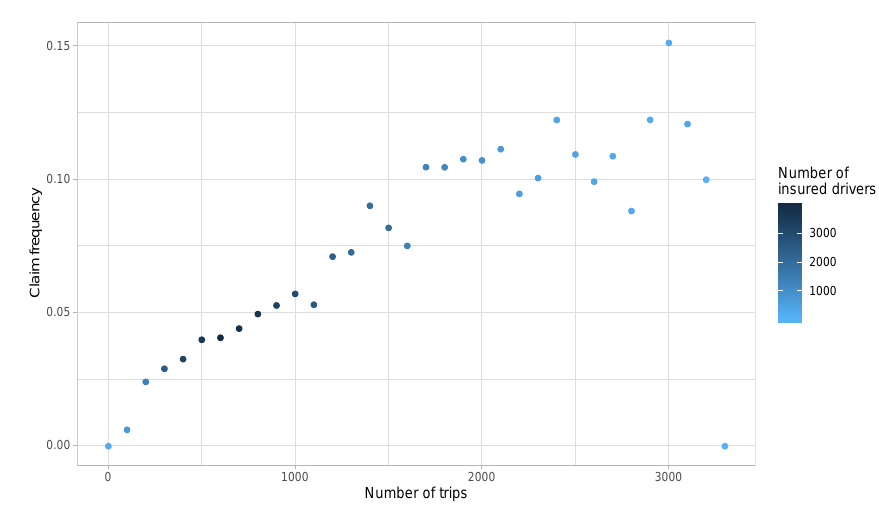
Figure 6. Claims Frequency vs. Distance Driven.